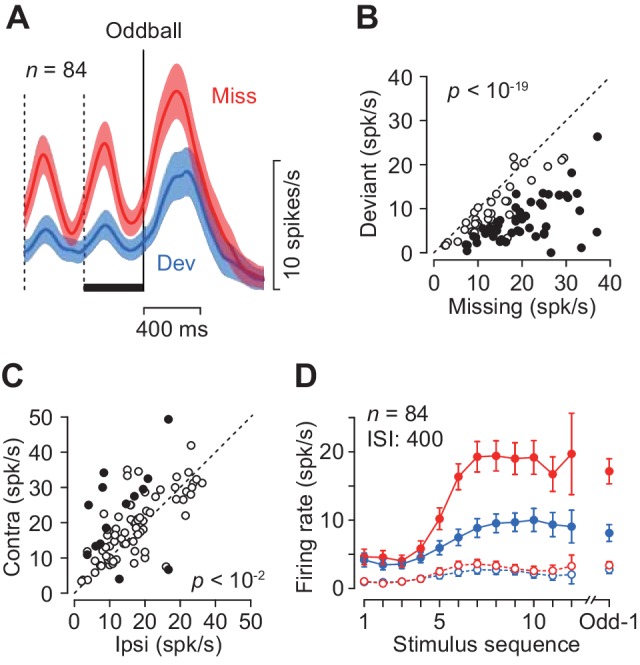
Quantitative comparison of neuronal activity between the missing and the deviant conditions.(A) Population activity of the increase-type neurons aligned with the oddball (vertical solid line). Shaded area indicates ± 95% CIs. (B) Effects of oddball conditions in individual neurons. The maximal firing rate was measured during a 100 ms window placed within the last inter-stimulus interval denoted by a black bar in A. Filled symbols indicate the data with a significant difference (Wilcoxon’s rank sum test, p<0.01, corrected). (C) Effects of saccade direction. Each data point compares maximal activity before the oddball between trials with opposite saccade directions. (D) The means of maximal (data connected with solid lines) and minimal (dashed lines) activities during each ISI as a function of time. Colors indicate different oddball conditions. Error bar indicates ± 95% CIs. Data are aligned with the beginning of the stimulus sequence (left panel) or the occurrence of the oddball (right).10.7554/eLife.48702.006Figure 3—source data 1.Numerical data for Figure 3.